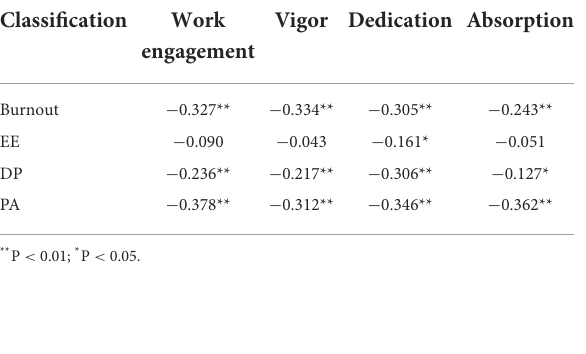
TABLE 3 Curve relationship. Model